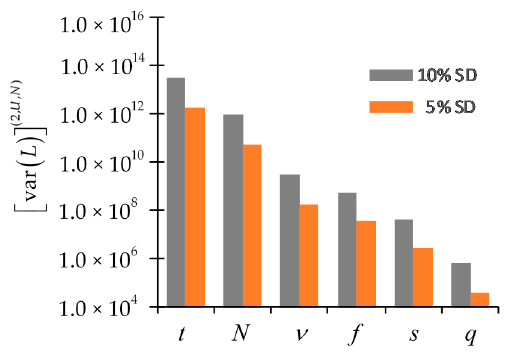
( ) (2, , ) var , , , , , , U N L i t N f s q ν=     , due to 5% and 10% standard deviations Figure 10. Comparison of i (SD) of the parameters (considered to be uncorrelated and normally distributed) underlying the total, scattering and fission cross sections, the average number of neutrons per fission, isotopic number densities, and the source parameters, respectively.